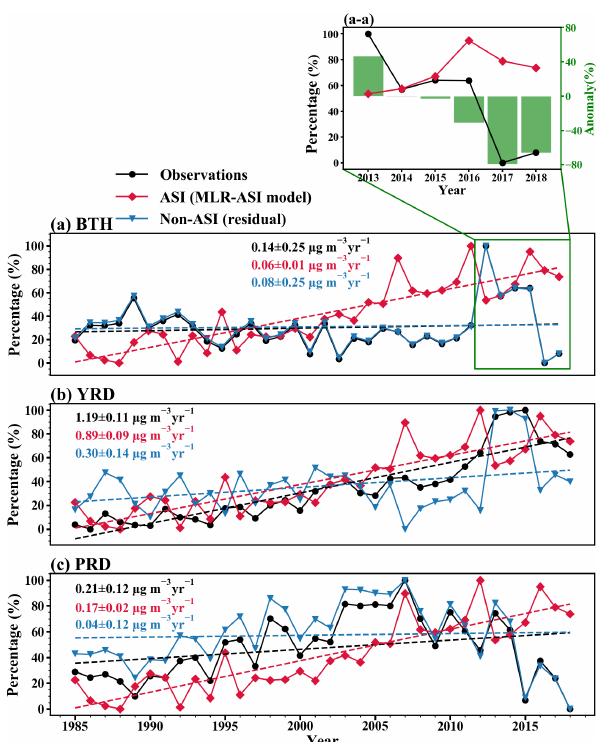
Figure 5. The same as Fig. 4 but for MLR-ASI